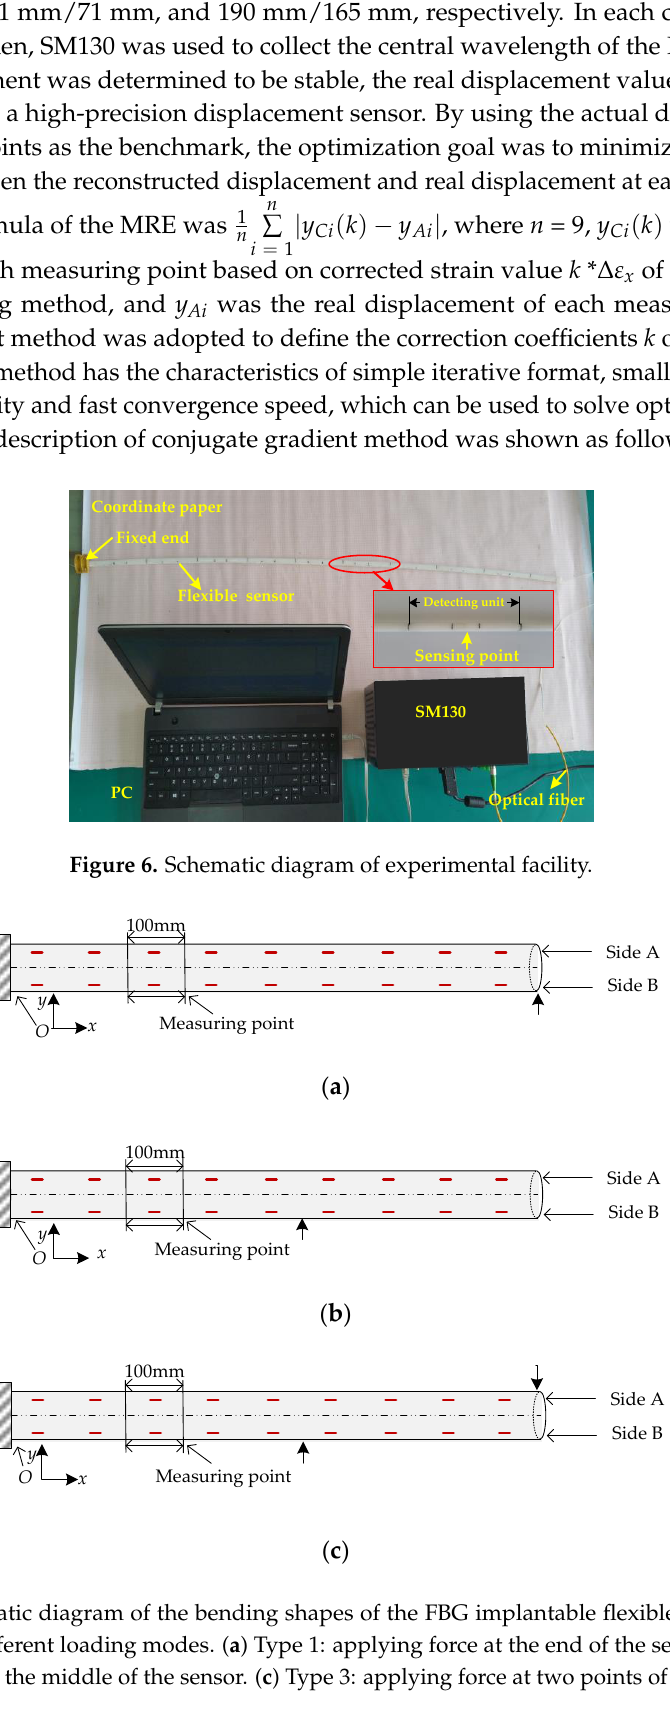
Figure 7. Schematic diagram of the bending shapes of the FBG implantable flexible morphological sensor under different loading modes. ( a ) Type 1: applying force at the end of the sensor. ( b ) Type 2: applying force at the middle of the sensor. ( c ) Type 3: applying force at two points of the sensor.